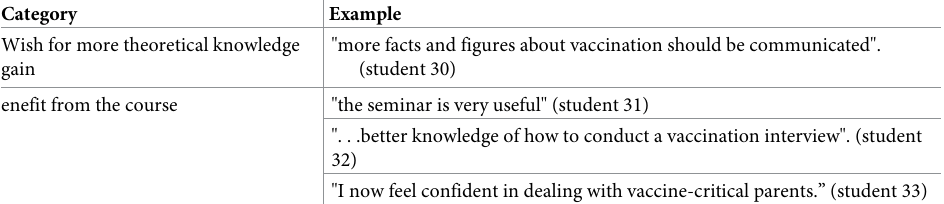
Table 3. Categories and corresponding examples based on medical students’ answers in the focus